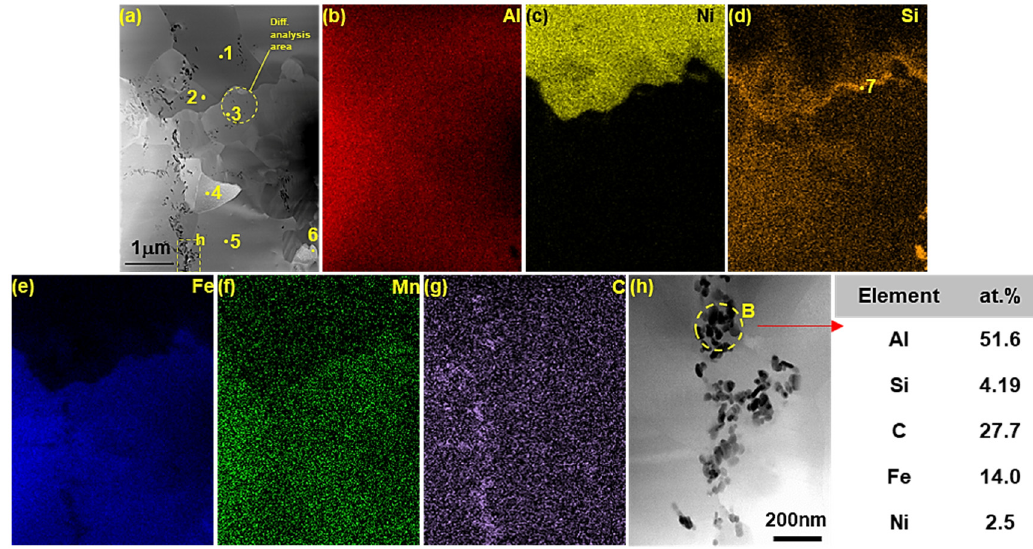
Figure 6. STEM results showing the focused ion beam (FIB) specimen extracted from the area denoted by X 1 in Figure 5: ( a ) high ‐ angle annular dark ‐ field (HAADF) image; ( b – g ) results of EDS: ( b ) Al, ( c ) Ni, ( d ) Si, ( e ) Fe, ( f ) Mn, ( g ) C; ( h ) black dot in h .